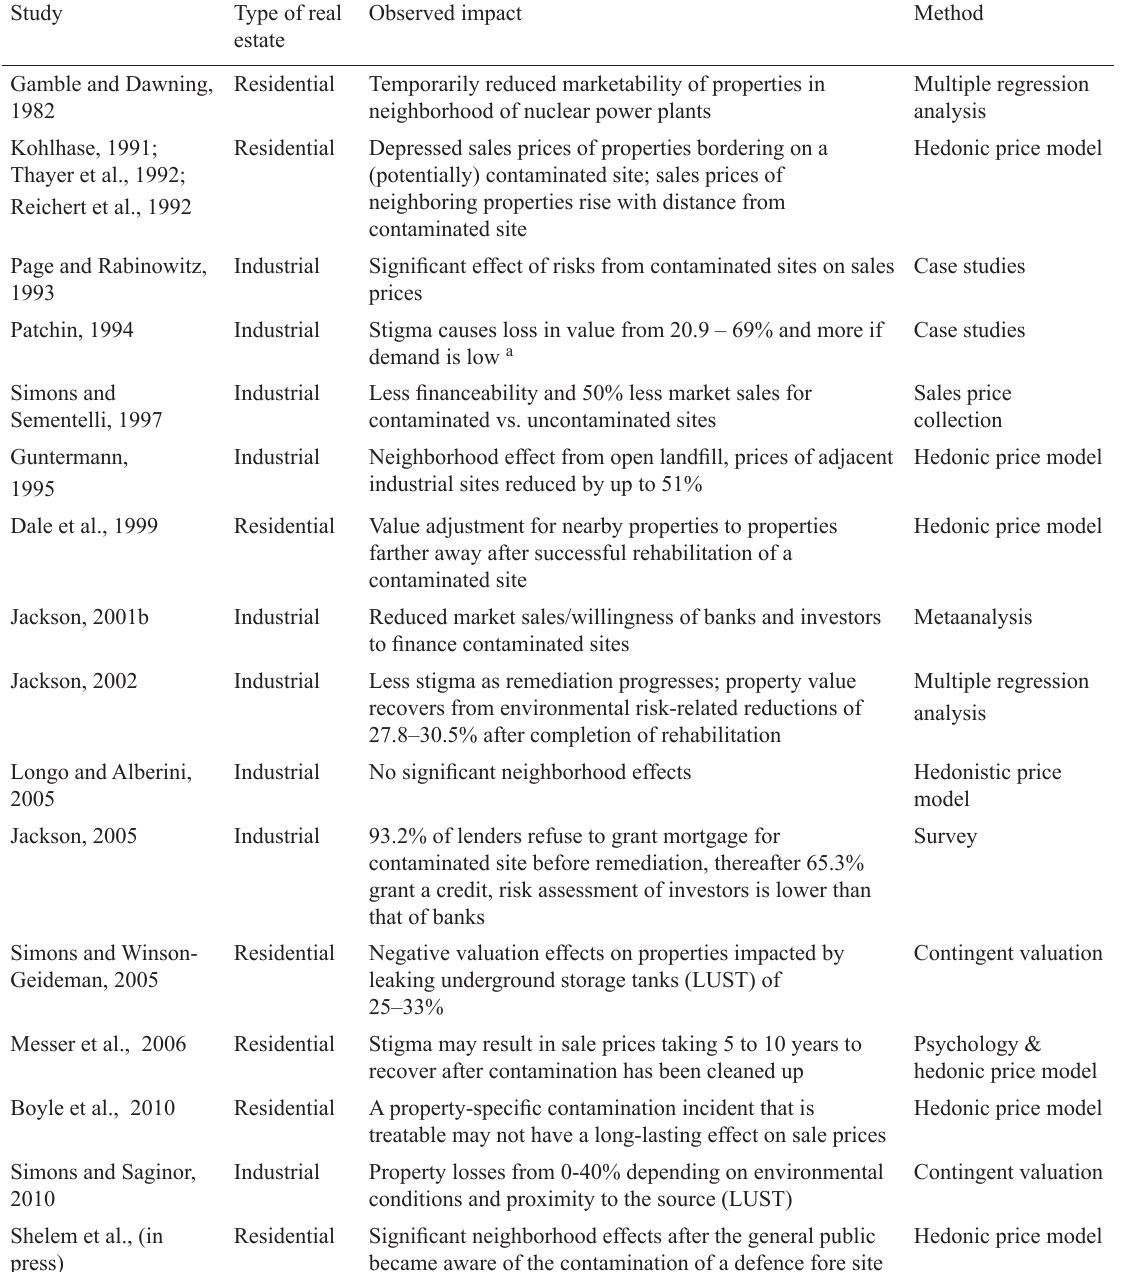
table 1. survey of exemplary empirical studies on the assessment of marketability risks of